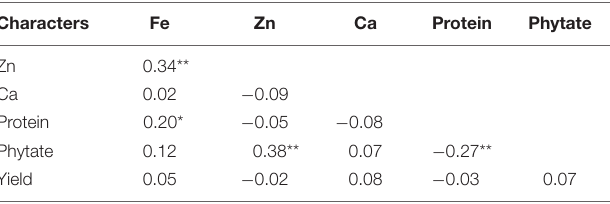
TABLE 6 | Correlation analysis among different grain nutrients and antinutrient composition in V. stipulacea accessions.